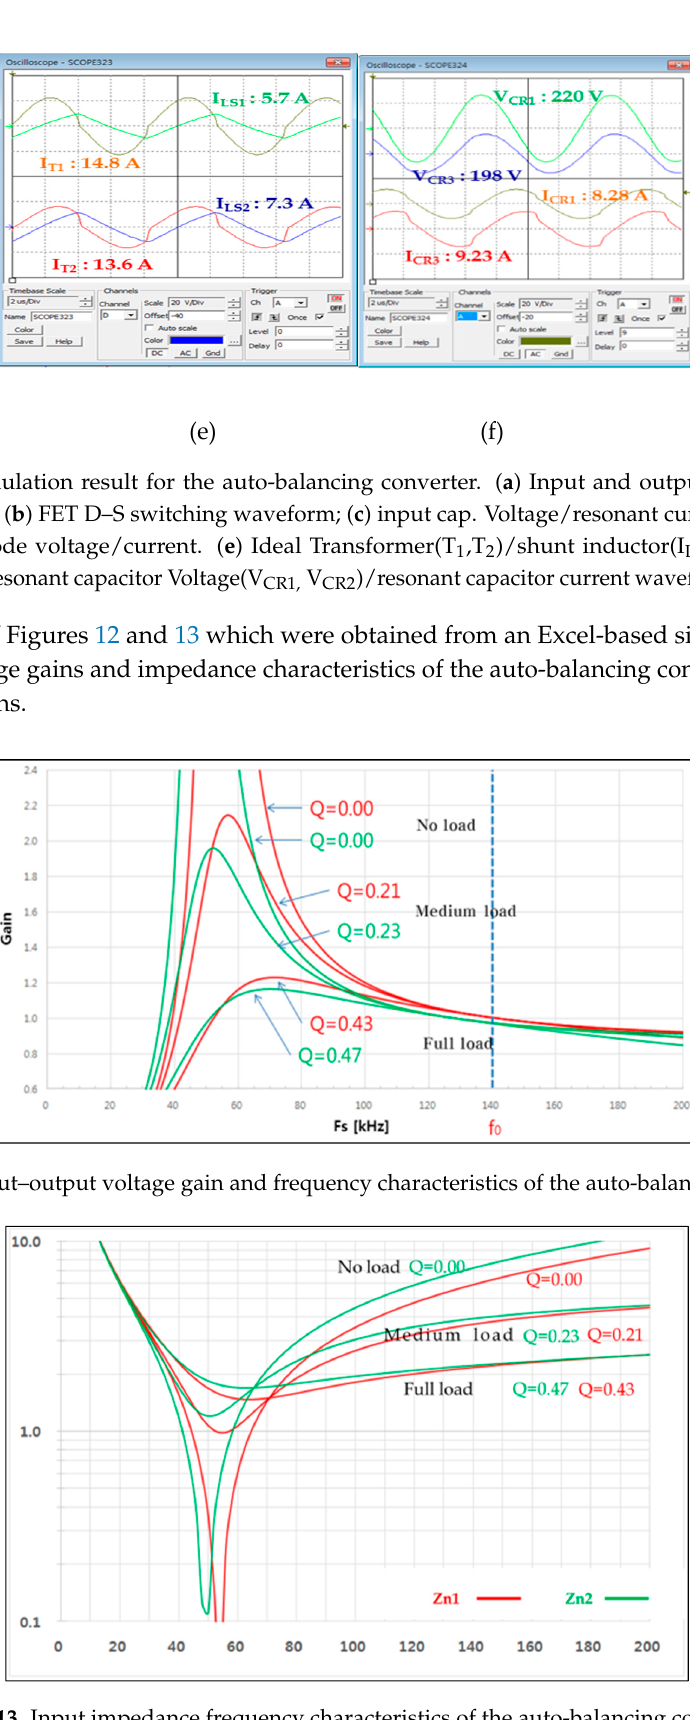
Figure 13. Input impedance frequency characteristics of the auto-balancing converter.